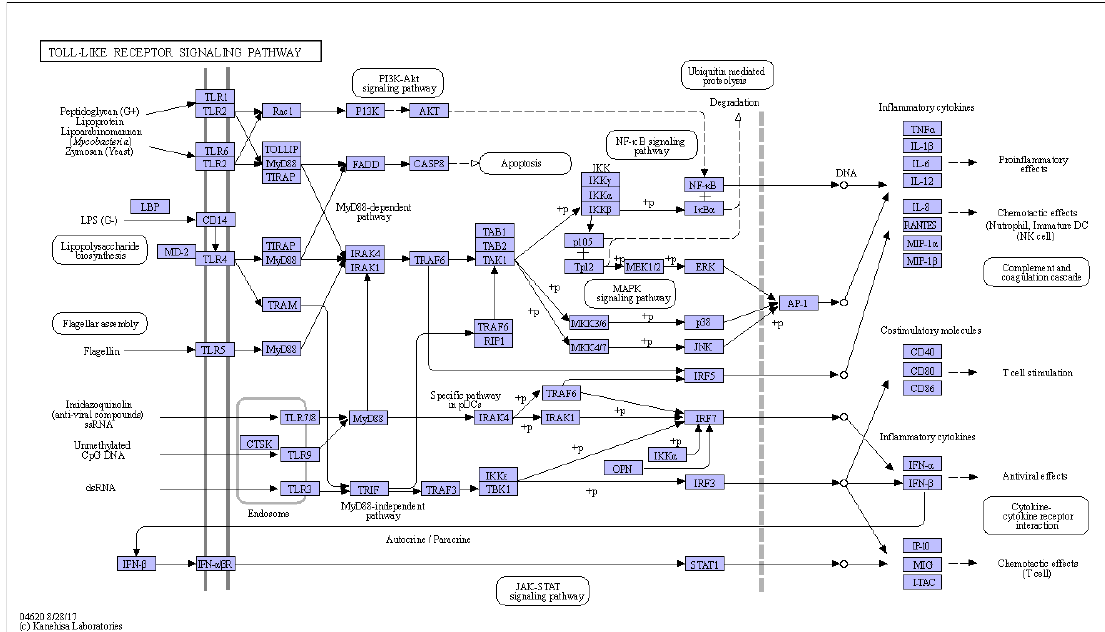
Figure 1. Overview of the toll-like receptor signaling pathway (https://www.kegg.jp/pathway/ko04620 (accessed on 28 August 2017)).